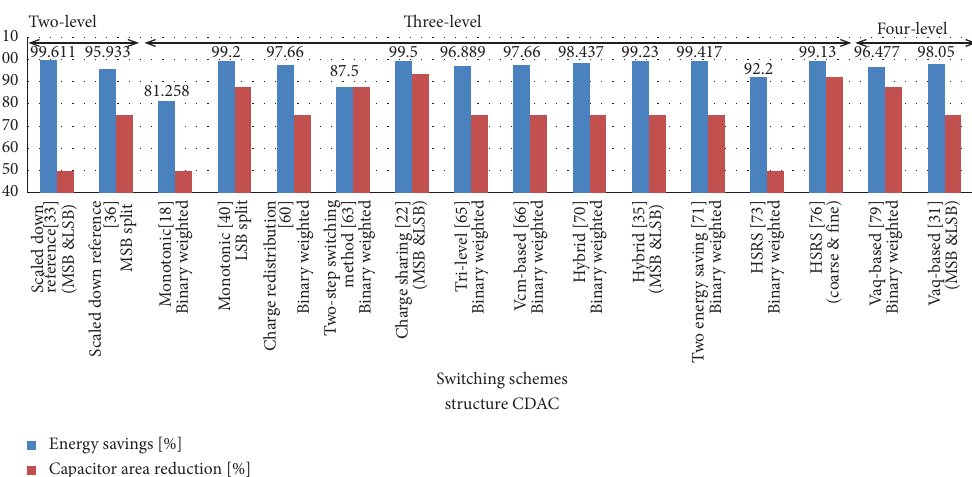
Figure 39: Some main CDAC structures and voltage switching schemes versus the